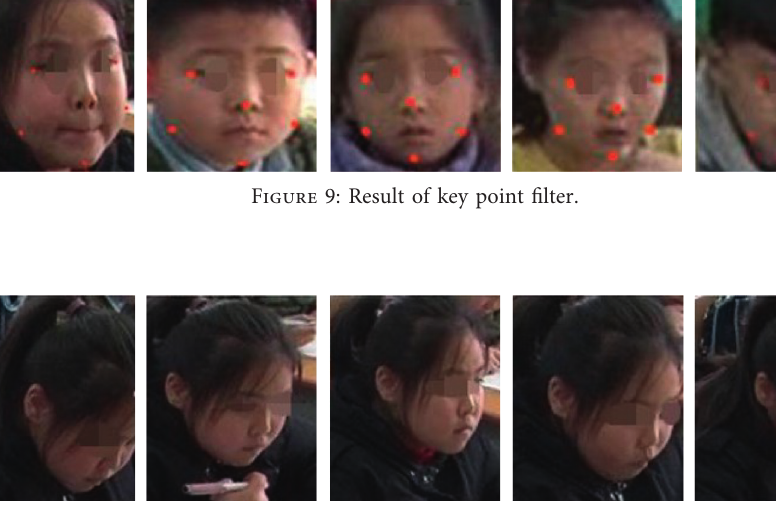
Figure 10: Example of student A concentrated status.